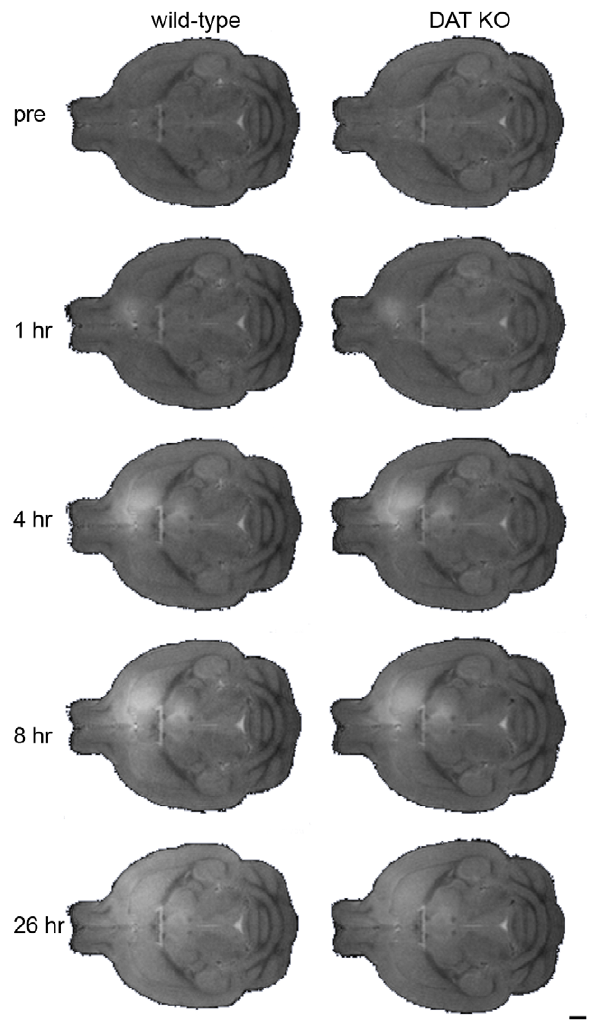
Figure 3. The minimum deformation template (MDT) images preserve the fidelity of the original images. The minimum deformation target (MDT) demonstrates preservation of the fidelity of the original images. Note the clarity of anatomical structures. The center of the injection site in the PFC is 1 mm above these transverse sections, which are at 2.8 mm below the brain surface. These sections illustrate the result of aligning all the DAT KO and WT in vivo MR images as described in Materials and Methods. Hyperintense regions indicate the location of Mn 2 + as it moves away from the injection site. Scale bar =1